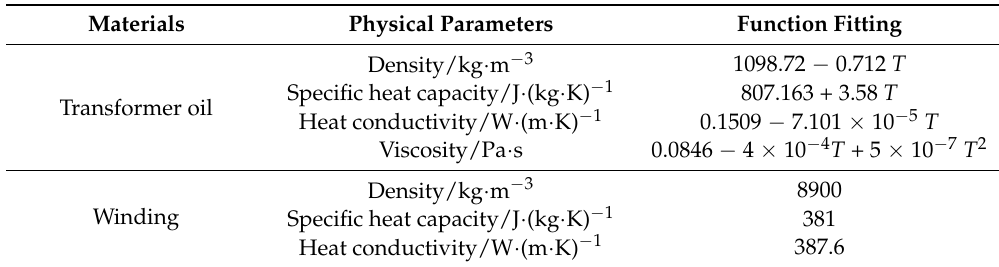
Table 2. Physical parameters of model.